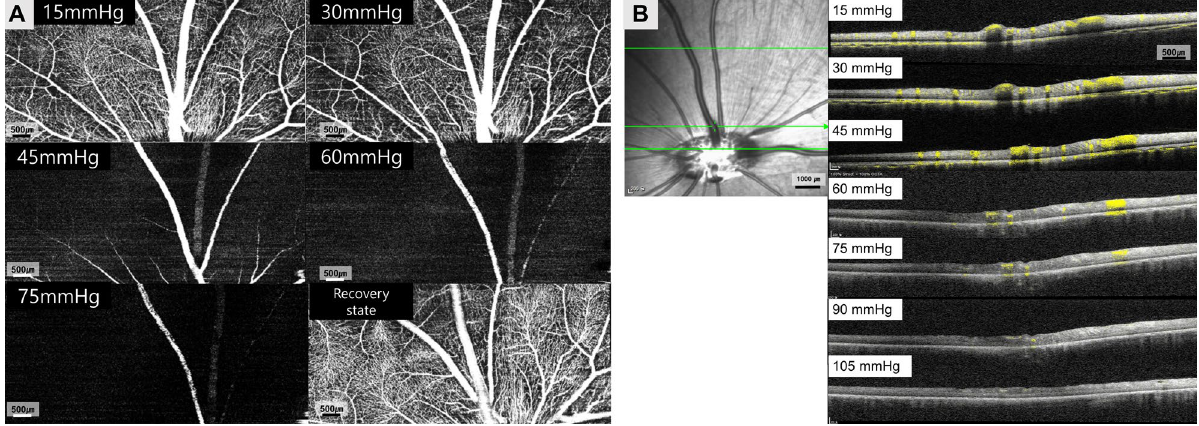
Figure 2. ( A ) Qualitative change in total retinal blood flow according to changes in IOP from 15 to 75 mmHg, and the recovery state. The fine end of capillaries which made inter-capillary connections seemed to be more diminished than capillaries connected to arterioles and venules at 30 mmHg of IOP. At 45 mmHg, a dramatic decrease in capillary flow was observed. Only major cilioretinal vessels and peripapillary vessels showed flow signal above 60 mmHg. In the recovery state, all of the major vessels and capillary flows seemed to recover their signal intensity. ( B ) Structural OCT + OCTA B-scan cross section image shows flow signal (yellowish dot) on structural OCT. When the intraocular pressure rises to 45 mmHg, the lumen of the major retinal vessels started to collapse and the vascular lumen flattened; capillary flow decreases as pressure rise. However, the flow signal still appears to be present in the cilioretinal arteries until an IOP of 75 mmHg. In the choroidal circulation, as shown in the en-face OCT, the flow reduction was clearly seen at 45 mmHg, and almost no flow signal was observed above 60